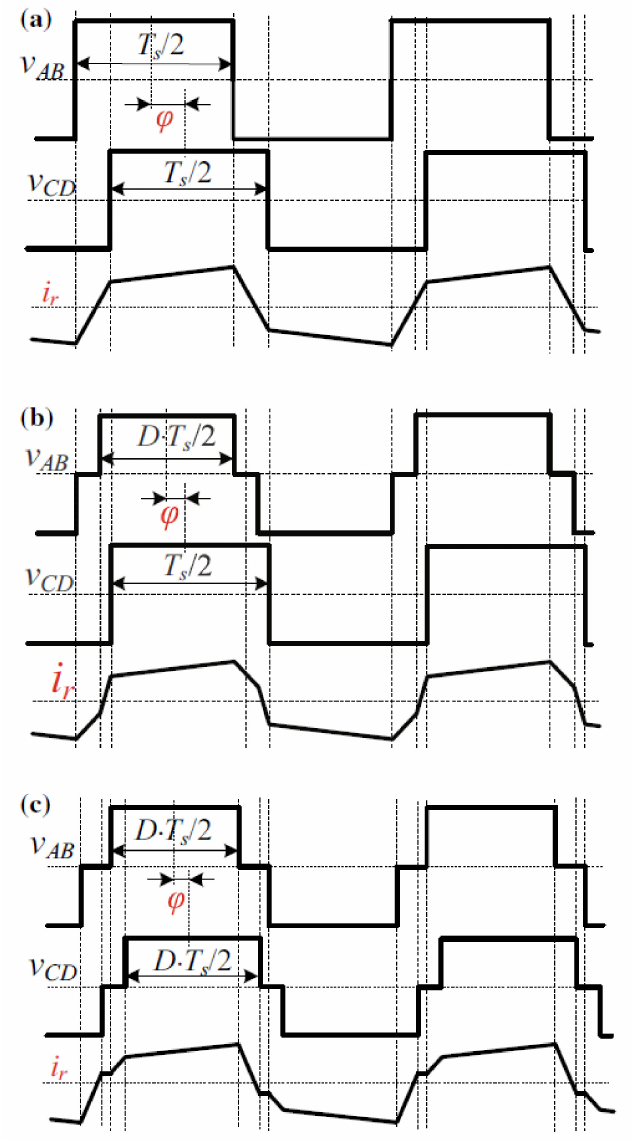
Figure 5. Waveforms of typical PS modulation schemes: ( a ) SPS; ( b ) EPS; ( c ) DPS